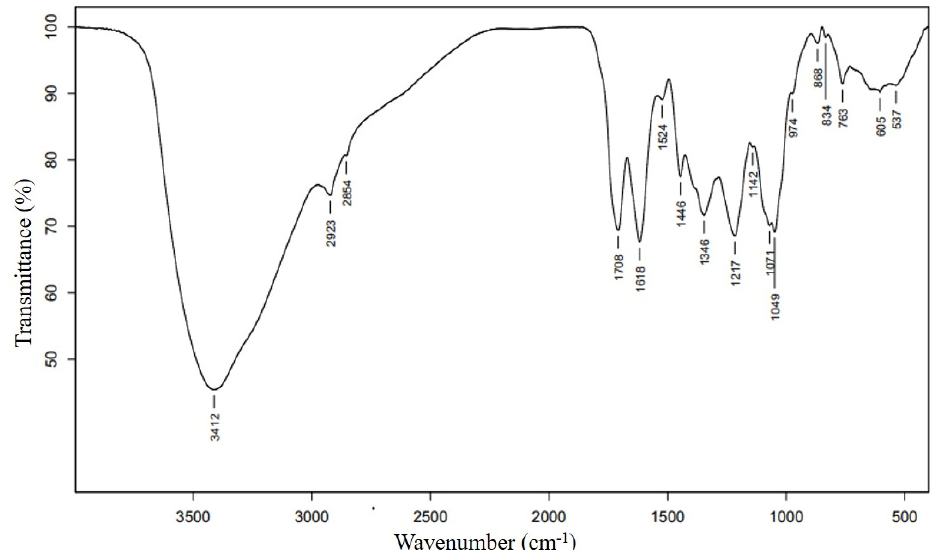
Figure 1. The FT-IR spectrum of rambutan peel extract (RPE). Table 2. Peak position (cm − 1 ) and tentative assignments of FT-IR absorbance bands for RPE recorded in the spectral region from 500 to 3500 cm − 1 .